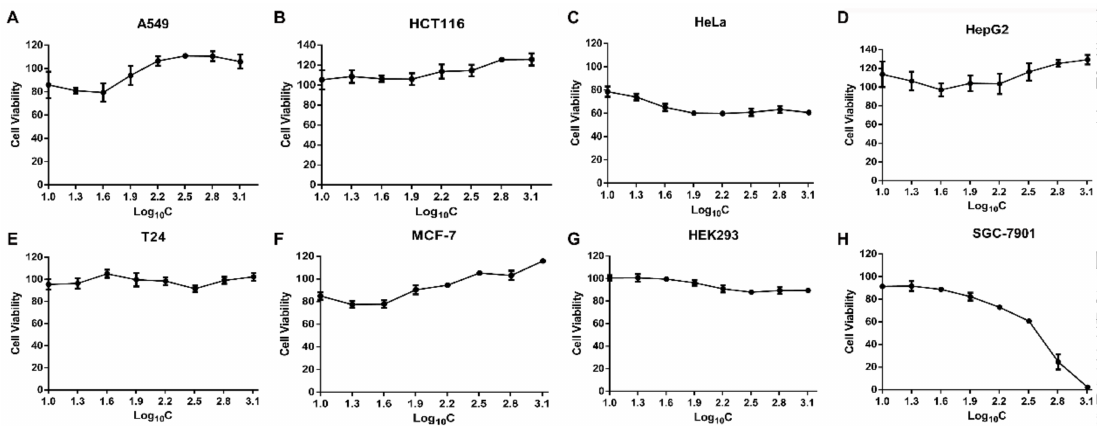
Figure 1. Cell proliferation evaluation by MTT assay under different concentrations of SPPH (silkworm pupa protein hydrolysate) treatment. ( A – H ) various human cell